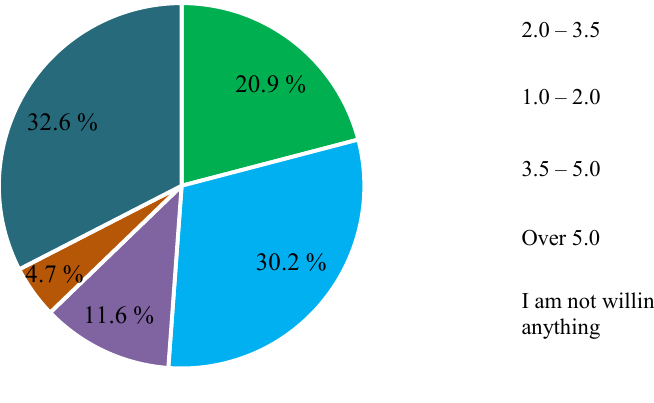
Fig. 5. Willingness to pay for installation of flue gas treatment equipment ( FGTE , capital investments), EUR/m 2 (considering area of the household).